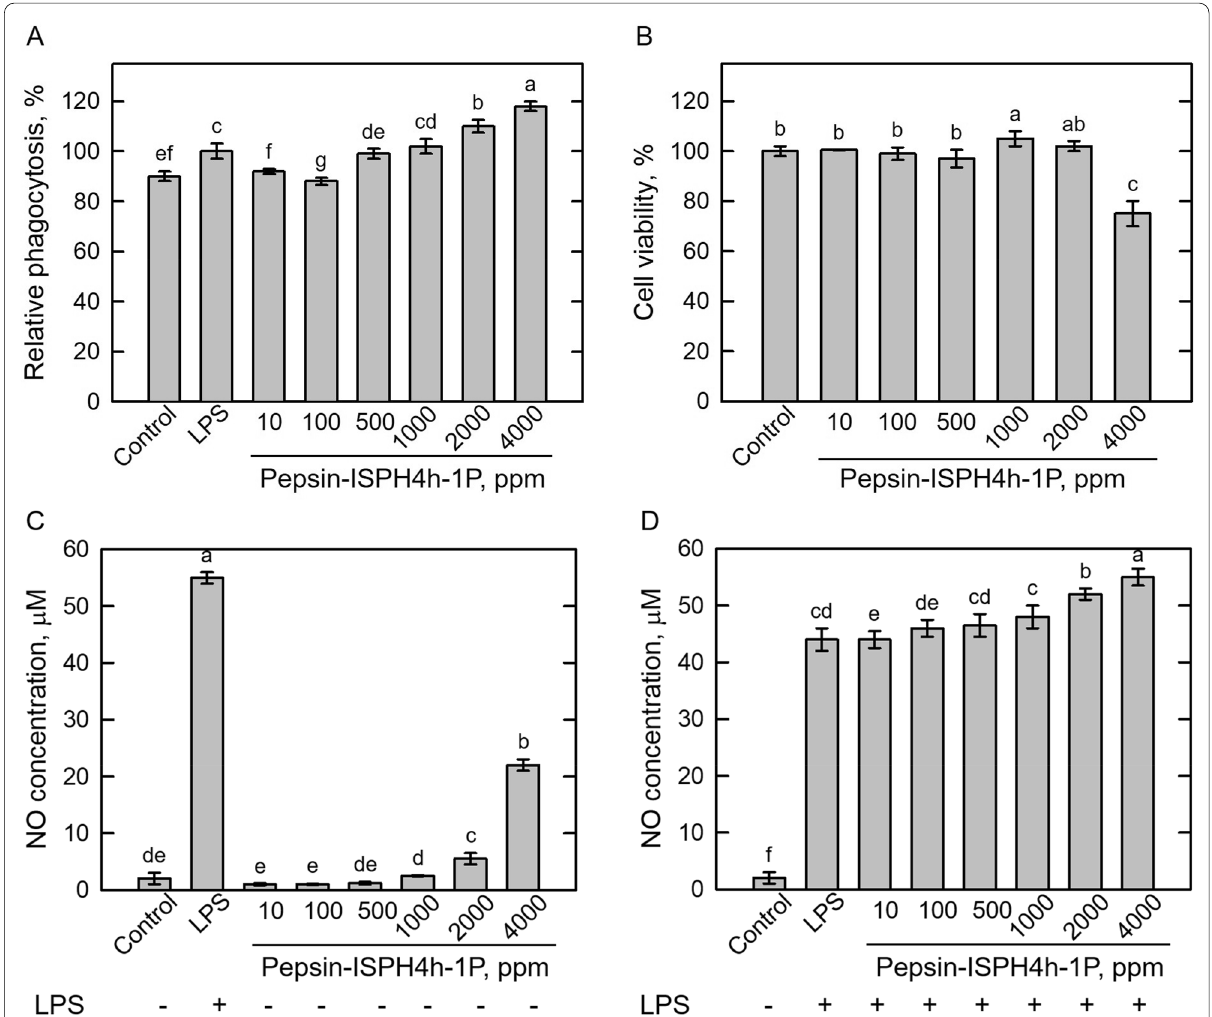
Fig. 3 Determination of anti‑inflammatory activity of Pepsin‑ISPH4h‑1P fraction. Dosage effect of Pepsin‑ISPH4h‑1P on relative phagocytosis (%, A ), cell viability (%, B ), and NO formation in the absence ( C ) or presence ( D ) of 1 ppm LPS in mouse macrophage RAW246.7 cells. Bars represent mean standard deviation (SD; n 3). Mean with different letters are significantly different ( p < 0.05) by Duncan’s multiple range ± =